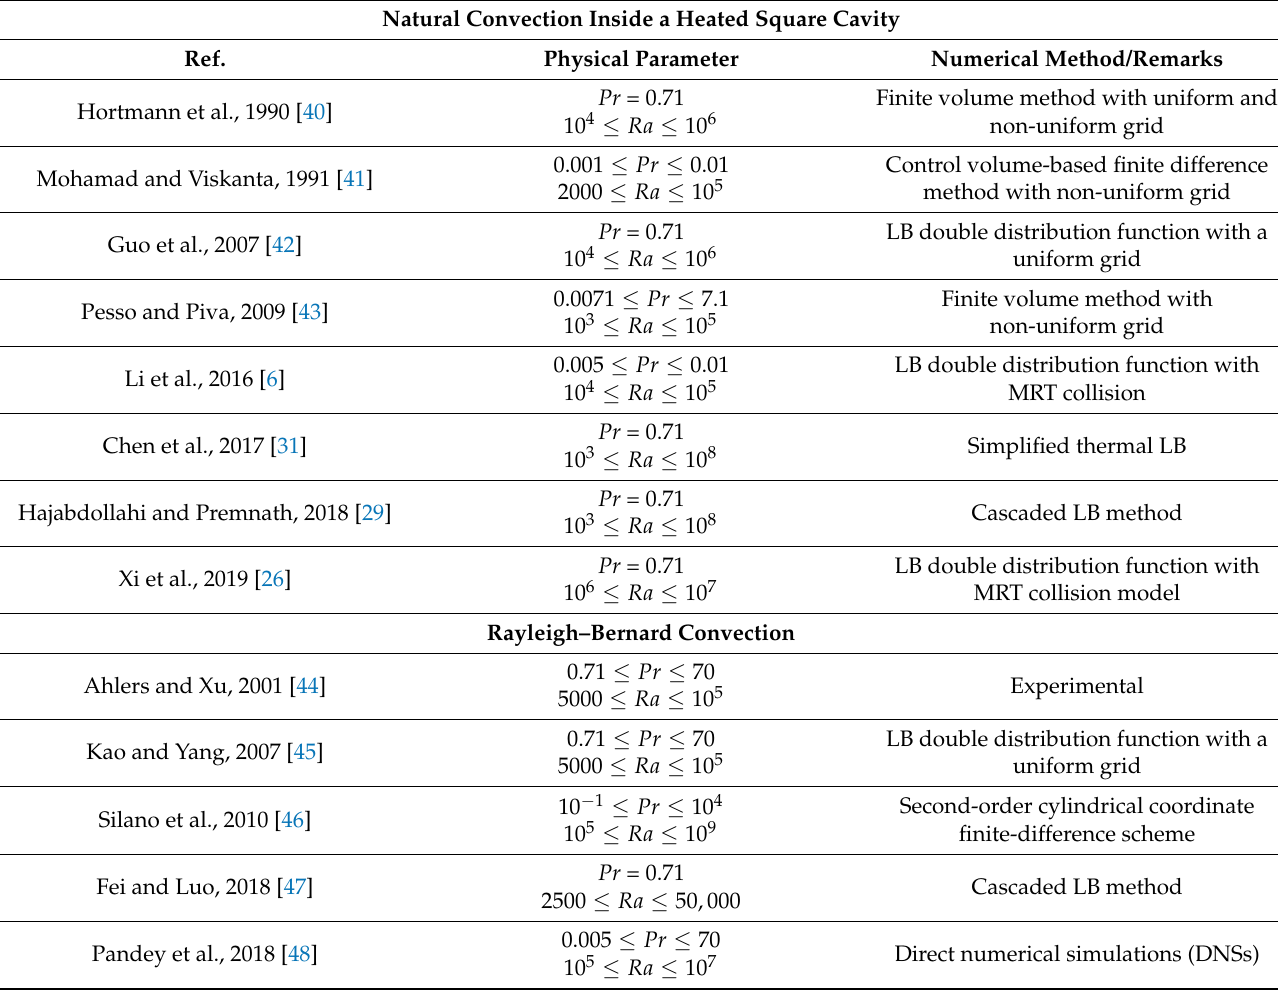
Table 1. A summary of the research works on natural convection inside a square